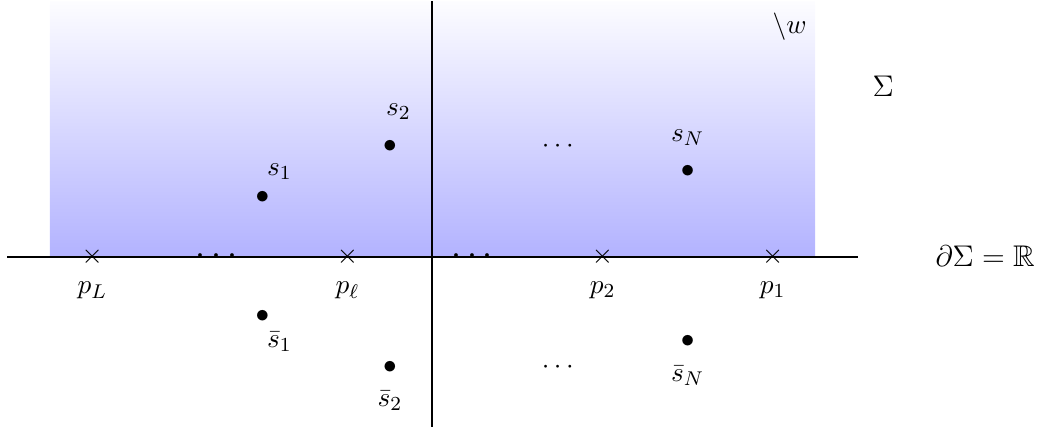
Figure 1 . The upper-half plane (cid:6) = H ; its boundary @ (cid:6) = R ; an array of zeros of the function (cid:21) at the points s n and poles at (cid:22) s n , with n = 1 ; (cid:1) (cid:1) (cid:1) ; N and Im ( s n ) > 0; and an array of poles of @ w A (cid:6) at the points p ‘ 2 R with ‘ = 1 ; (cid:1) (cid:1) (cid:1) ; L